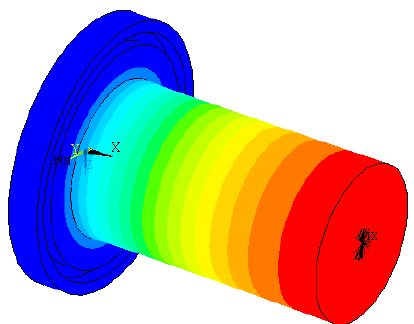
Figure 5. Vibration mode shape of cylindrical horn at frequency of 67.533 kHz.